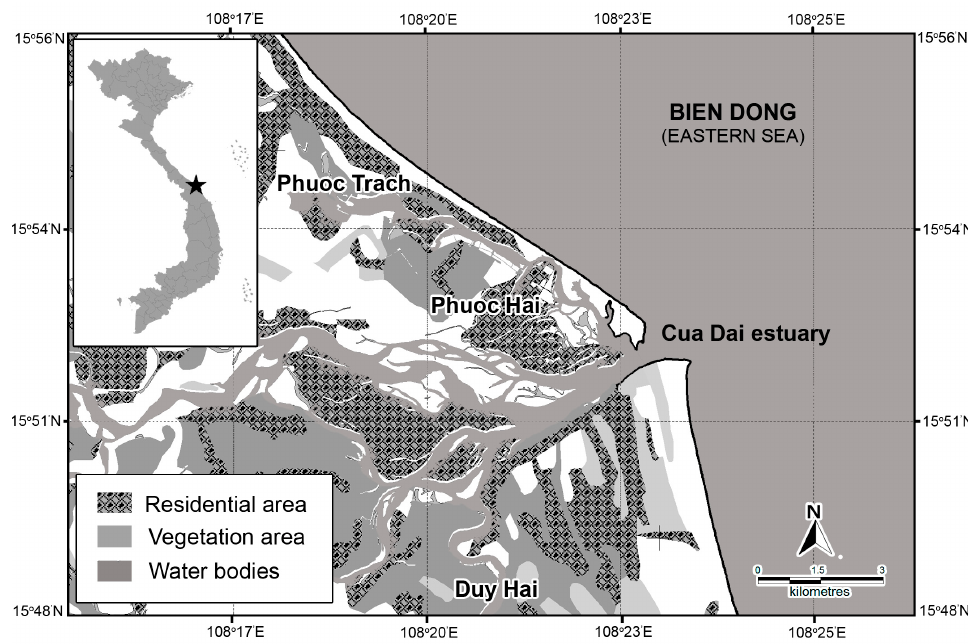
Figure 1. Location map of the Cua Dai estuary in Central Vietnam.